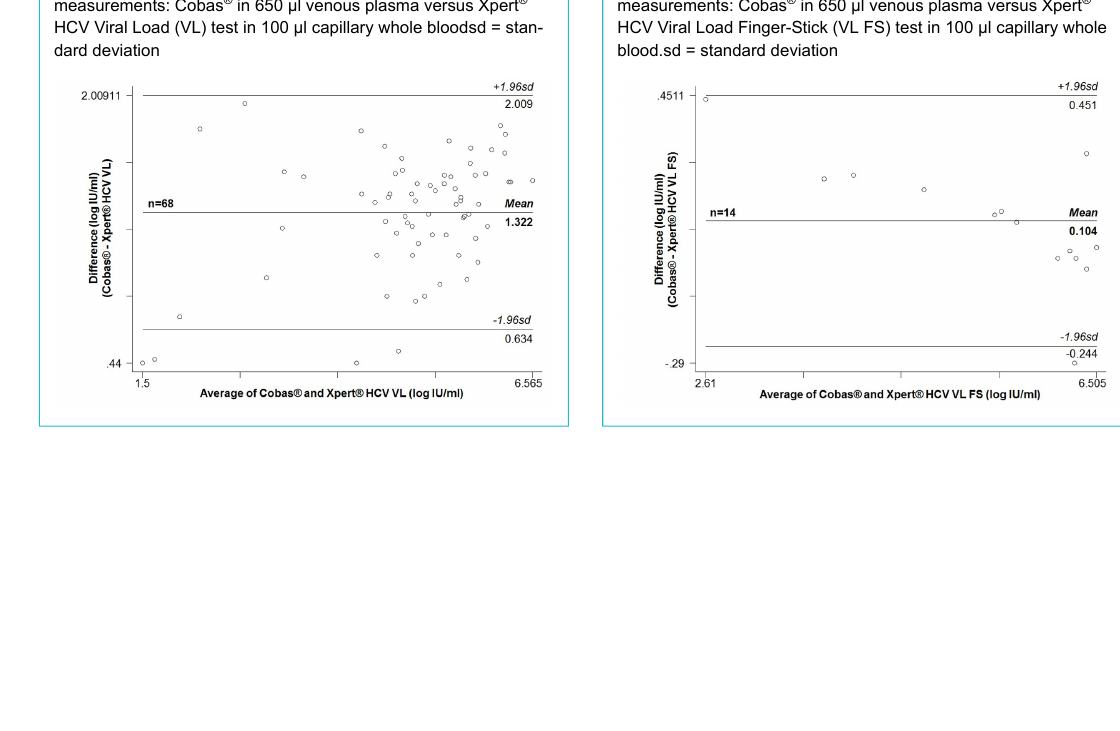
Figure S3: Bland-Altman plot of 14 paired quantifiable HCV RNA measurements: Cobas ® in 650 µl venous plasma versus Xpert